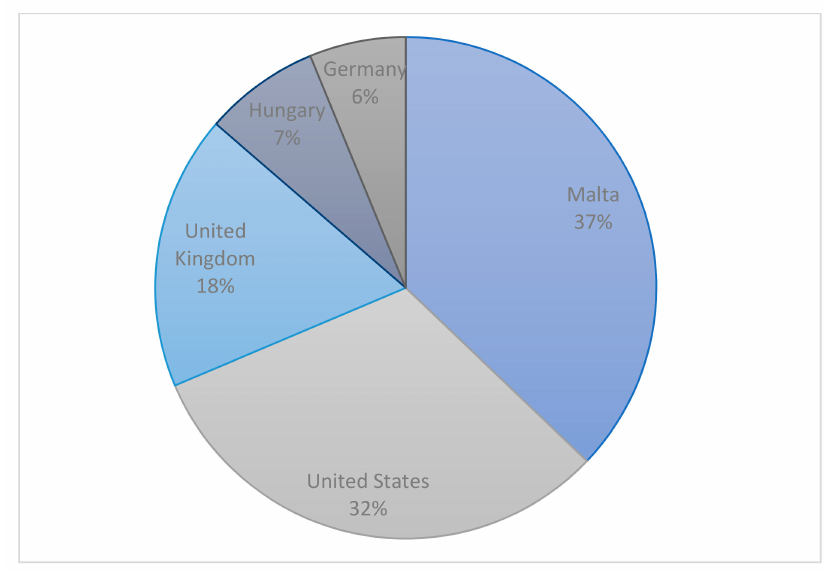
Figure 12. Early visitor numbers (July–August